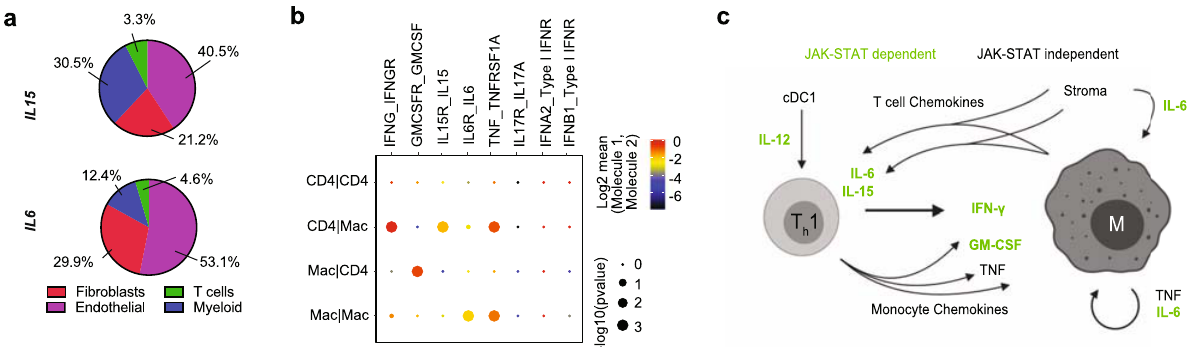
Fig. 8 Cell type speci fi c receptor-ligand analysis and summary in sarcoidosis. a Pie chart showing relative proportions of IL15 and IL6 producing cells in sarcoidosis scRNA-seq data from skin (see also Supplementary Fig. 7). b Dot plot of cellphone DB receptor-ligand interaction analysis for select receptor- ligand pairs, p value as determined using Cellphone DB script. c Summary of central cytokine and chemokine signals in sarcoidosis revealed by scRNA-seq and